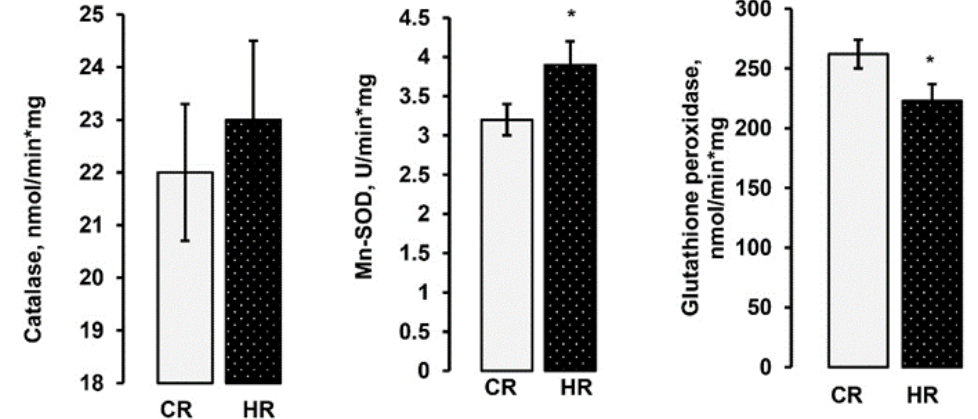
Figure 3. Activities of antioxidant enzymes in the heart mitochondria of control and hyperthyroid rats. CR-control, HR-hyperthyroidism. * p < 0.05, the difference is statistically significant ( n = 15 in each group).